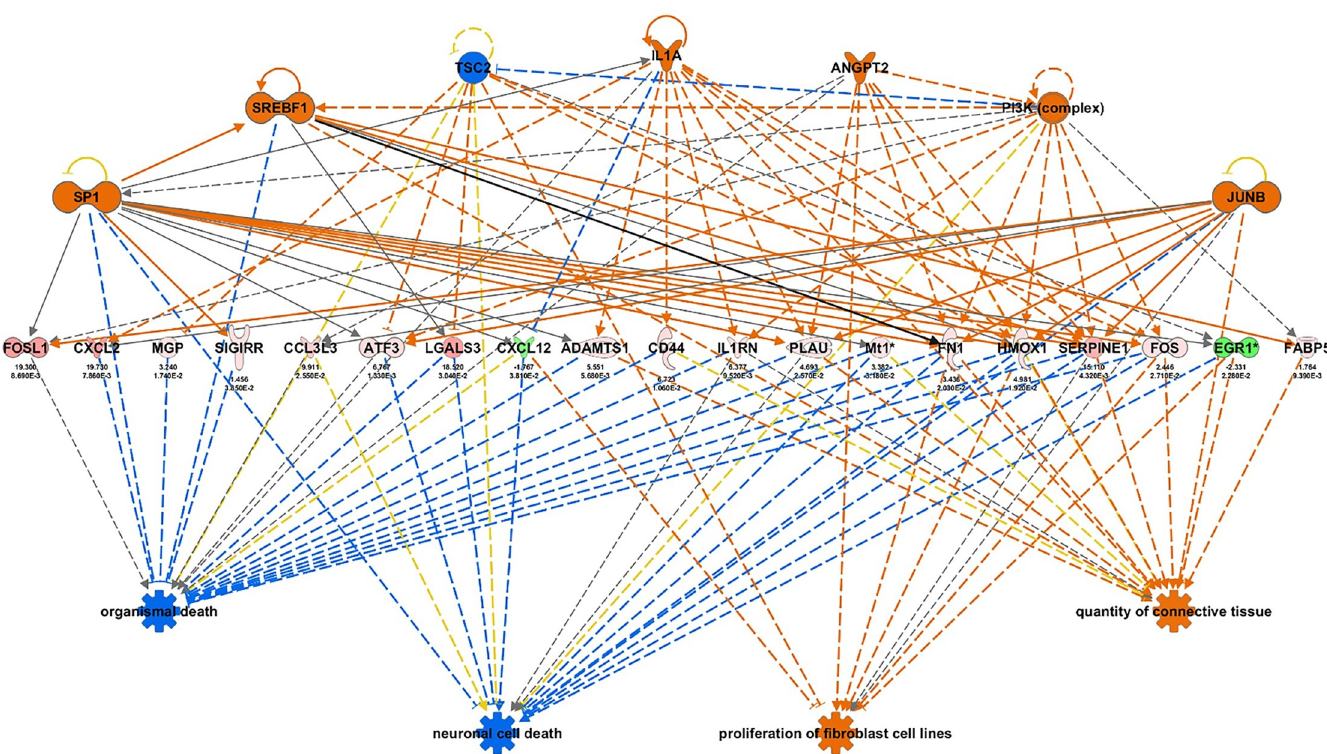
Fig 9. Regulator effects hippocampal network in ingenuity pathway analysis (IPA). Example of integrated results from Upstream regulator and Downstream effects analyses in IPA indicating potential phenotypes or biological impact of TBI-dysregulated genes at 24 hr after TBI in hippocampus. Upstream genes are key hub genes and transcriptional regulators in essential cell signaling networks.